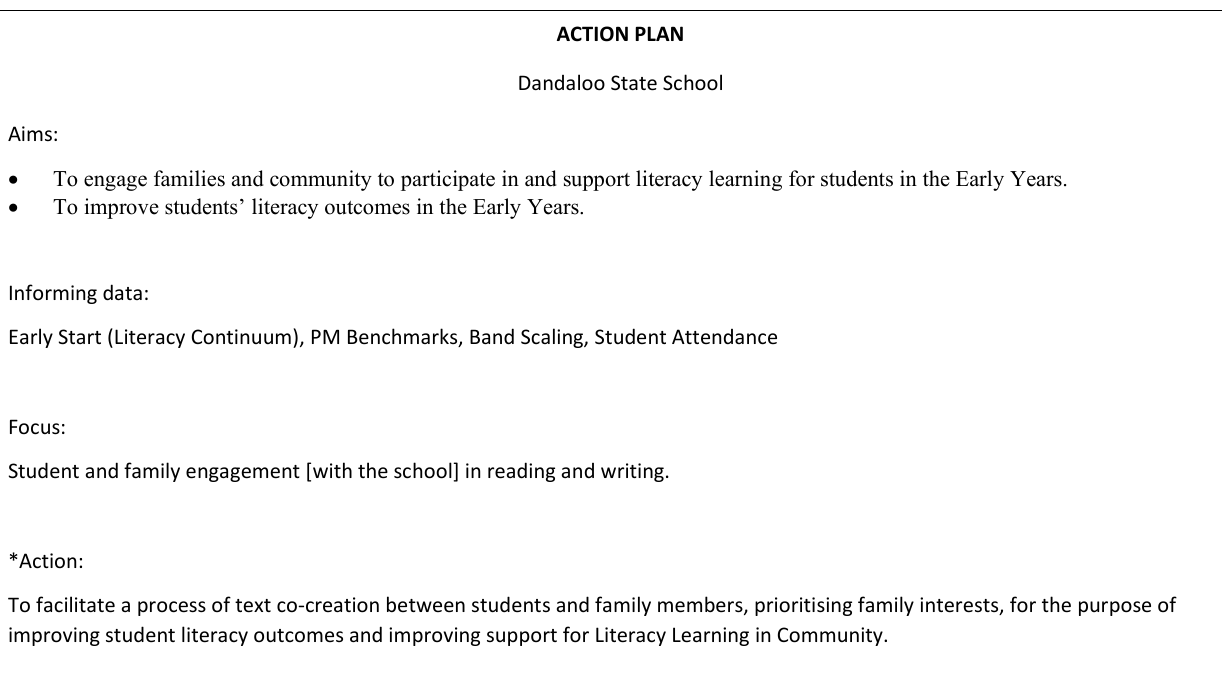
Figure 3. Action plan (with all names